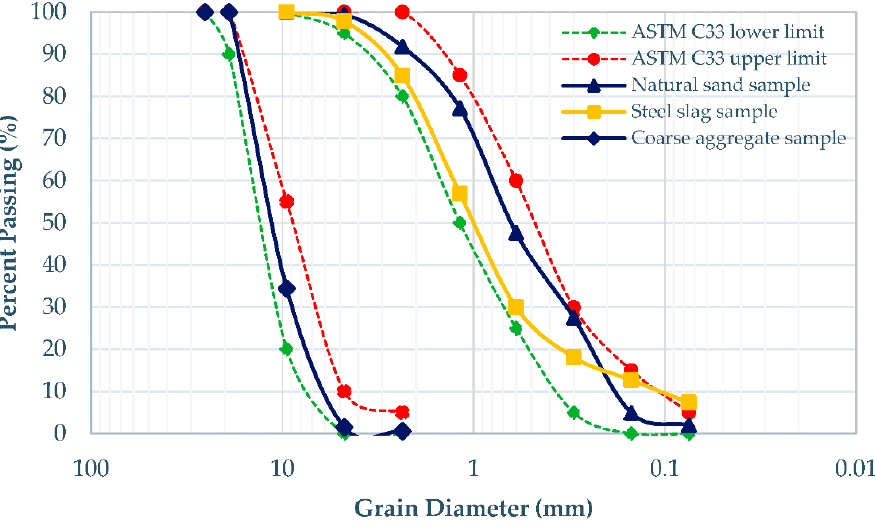
Figure 1. Particle size distribution curves of coarse and fine aggregates. Table 2. Physical properties of natural sand and steel slag.